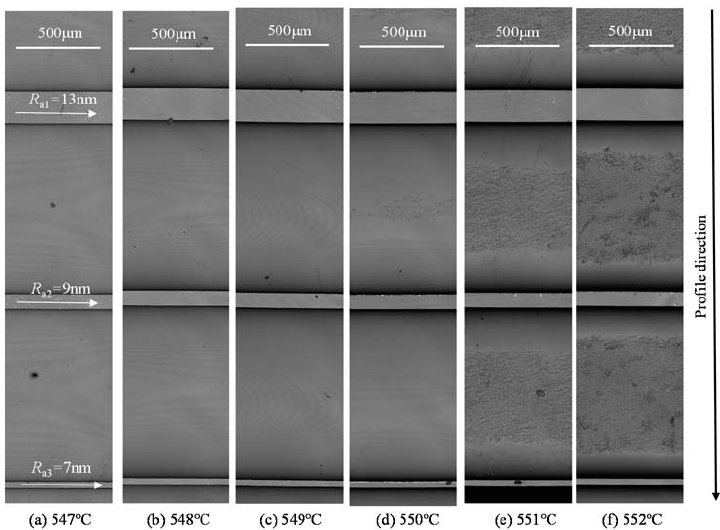
Figure 4. The molded grooves at different molding temperatures ( P = 0.3 MPa). ( a ) 547 °C; ( b ) 548 °C; ( c ) 549 °C; ( d ) 550 °C; ( e ) 551 °C; ( f ) 552 °C. ( c ) 549 ◦ C; ( d ) 550 ◦ C; ( e ) 551 ◦ C; ( f ) 552 ◦